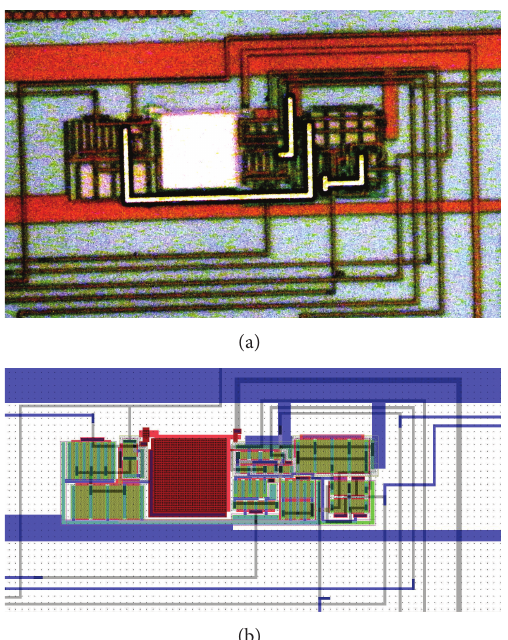
Figure 8: Memory cell microphotograph and layout.